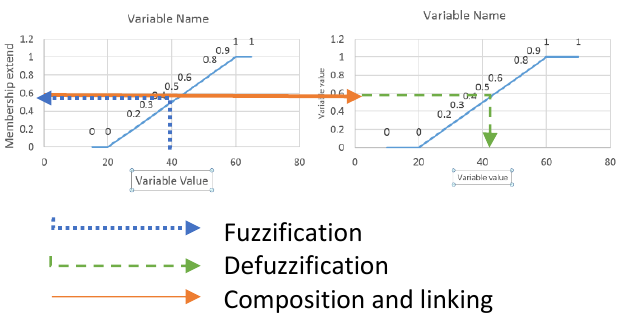
Fig. 3. Output composition and